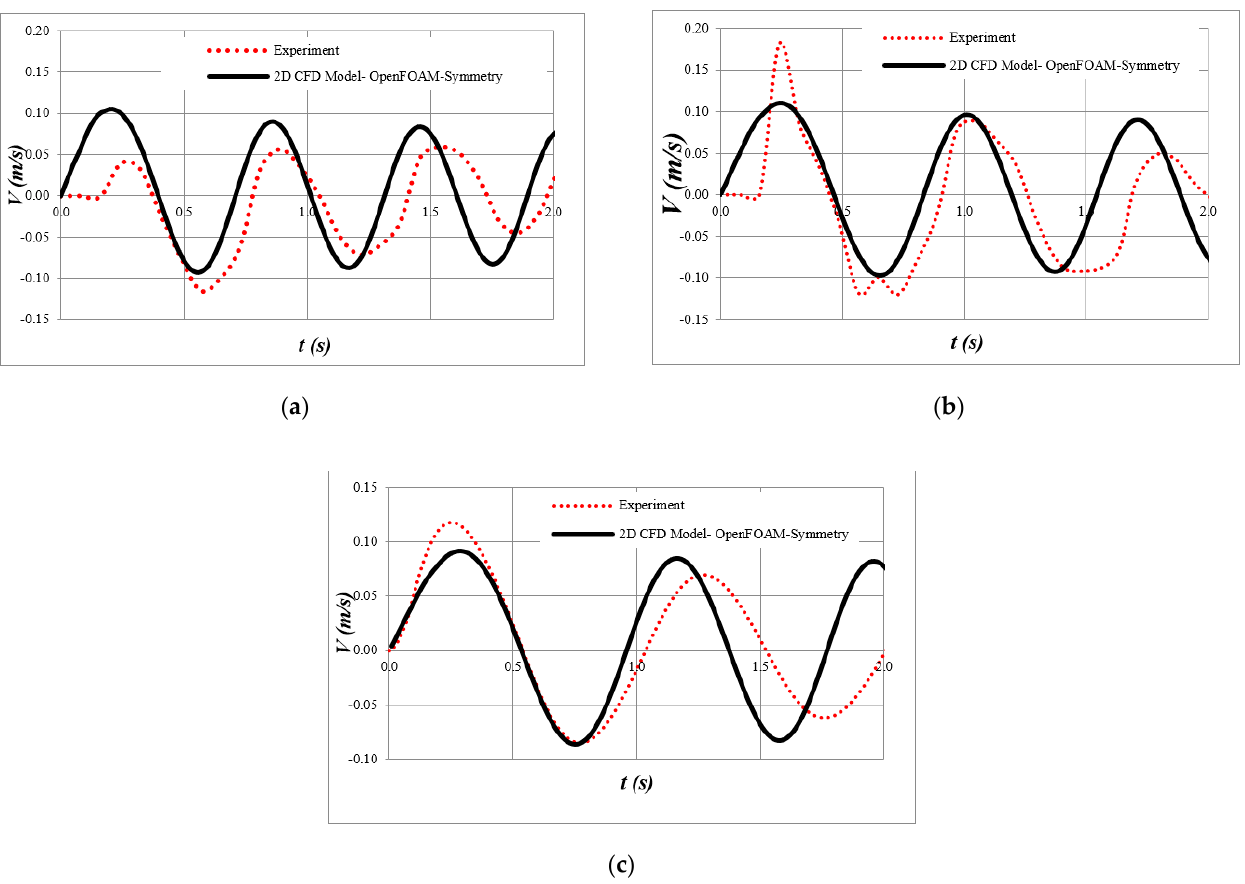
Figure 6. Comparison of water velocity patterns between the experimental model and the 2D CFD OpenFOAM symmetry model for cases B: ( a ) run B4; ( b ) run B5; ( c ) run B6.